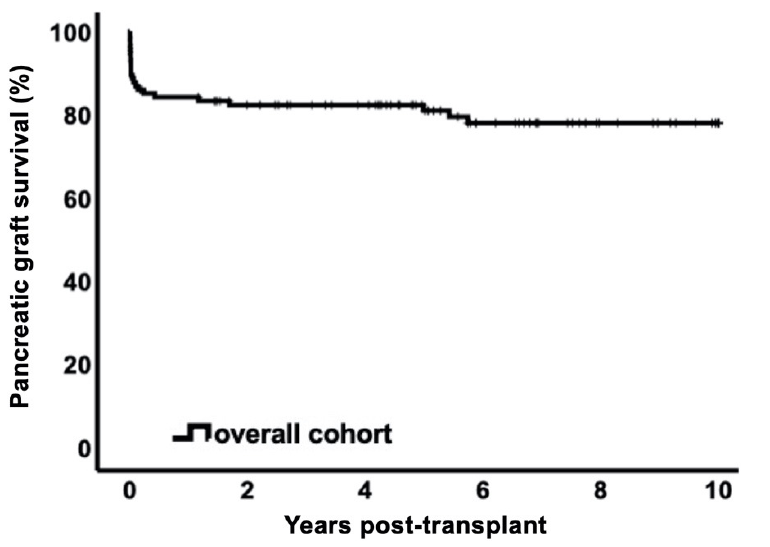
Figure 1. Kaplan–Meier curve for pancreatic graft survival censored for death over 10 years (78.0% (CI95% 69.8–86.2)). Of note, pancreatic graft loss mostly occurred in the first 3 months.